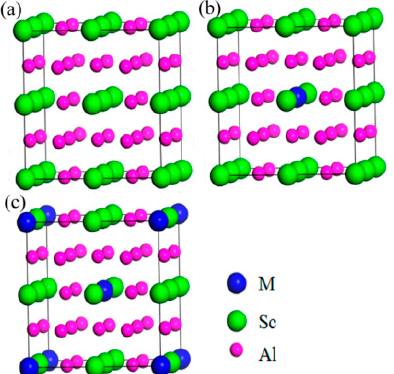
Figure 17. Structures of Al 3 Sc cell structure of alloy elements (M = Sc, Zr, Ti, Y, Li) doped with dif-